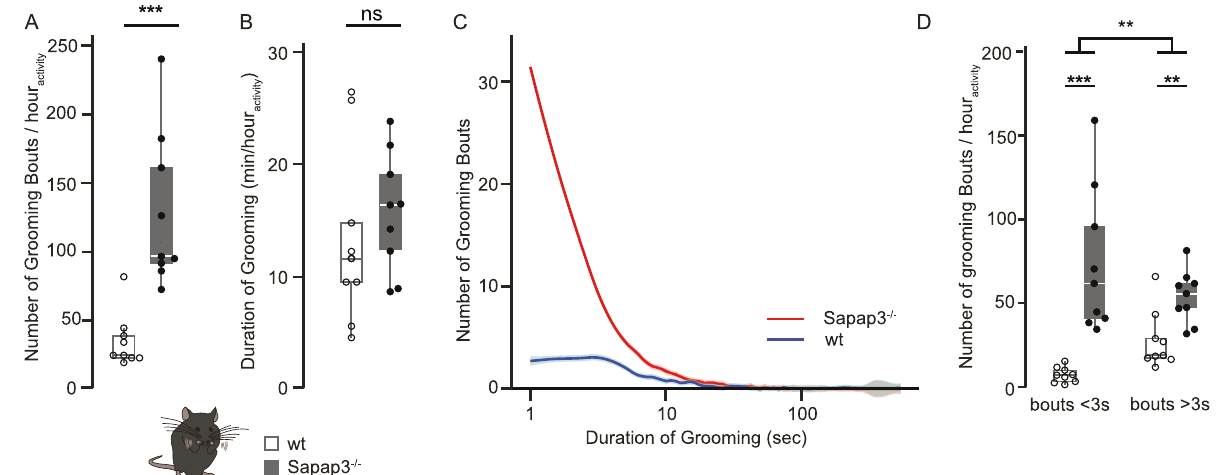
Fig. 3 Short, single-phase grooming events are more exaggerated than syntactic grooming in Sapap3 − / − mice. A Sapap3 − / − mice show signi fi cantly more grooming events compared to wildtype controls (Mann – Whitney U test, p < 0.001). B Total grooming duration is comparable between Sapap3 − / − and wildtype mice (Mann – Whitney U test, p = ns). C Self-grooming behaviour of Sapap3 − / − mice compared to wildtype mice is characterised by a large proportion of grooming events of short duration. The x -axis is depicted on a log 10 scale. D Both short grooming events (<3 s duration) as well as long grooming events (>3 s duration) were signi fi cantly enhanced in Sapap3 − / − mice compared to wildtype controls (Mann – Whitney U , p < 0.001 and p < 0.01, respectively). Self-grooming behaviour depended both on genotype and bout length (ARTANOVA, p genotype*grooming type < 0.01). All plots illustrate data from n = 9 Sapap3 − / − and n = 9 wildtype mice; box whisker plots were designed as described in the legend of Fig. 2. ** p < 0.01; *** p < 0.001; ns non-signi fi